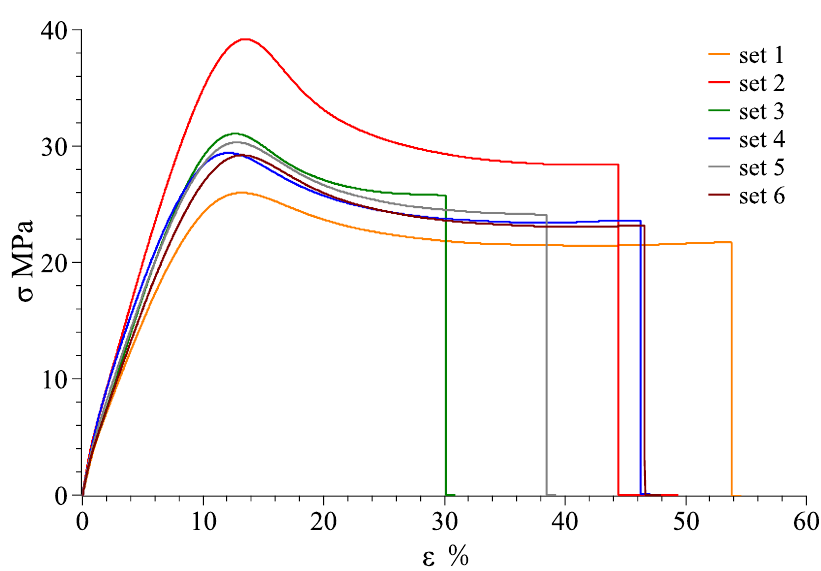
Figure A4. D8520, D8530 stress–strain curve for the X-axis (6 specimens).